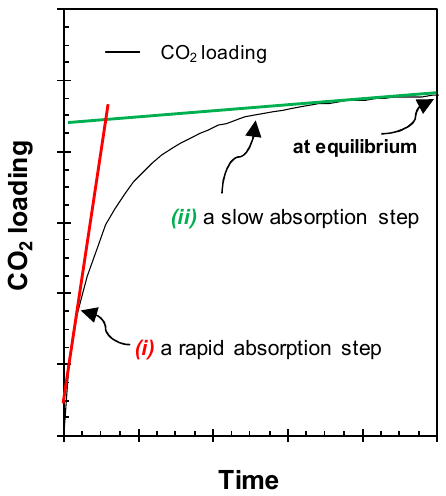
Figure 5. CO 2 capture using EDA: kinetic mechanism proposal. Equation (7) is the mathematical expression for the kinetic mechanism proposal. The first term corresponds to the CO 2 loading at equilibrium. The parameters ( A 1 , k 1 , A 2 , k 2